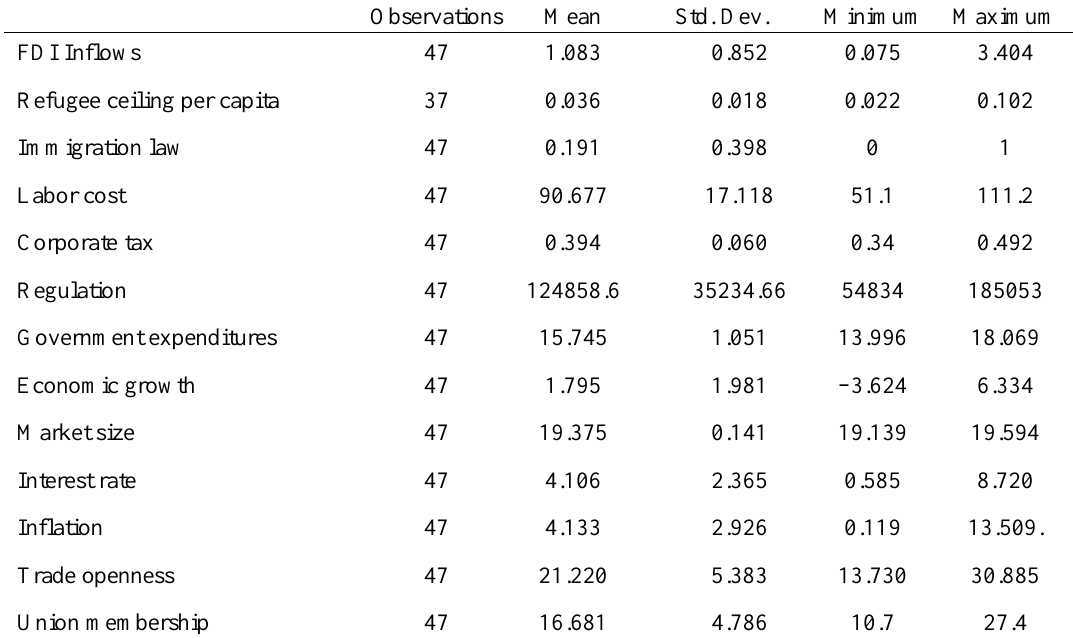
Table 1:. Descriptive